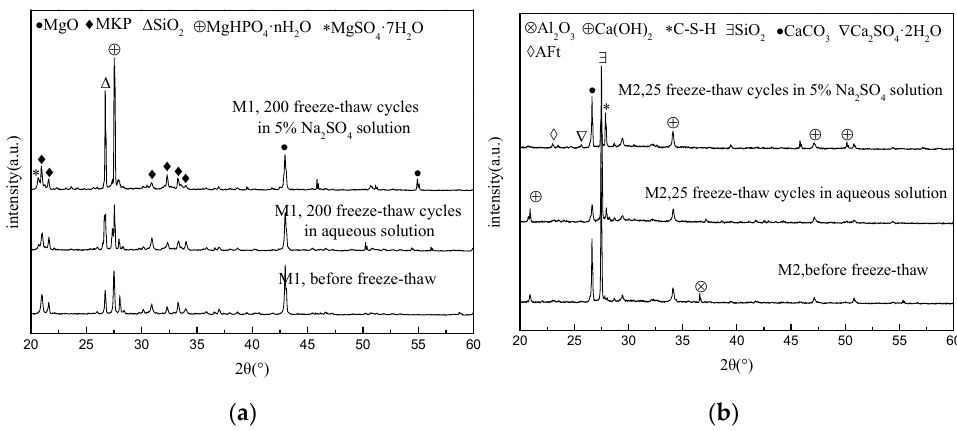
Figure 6. XRD patterns of MKPC mortar samples and P.O mortar samples. ( a ) M1; ( b ) M2.